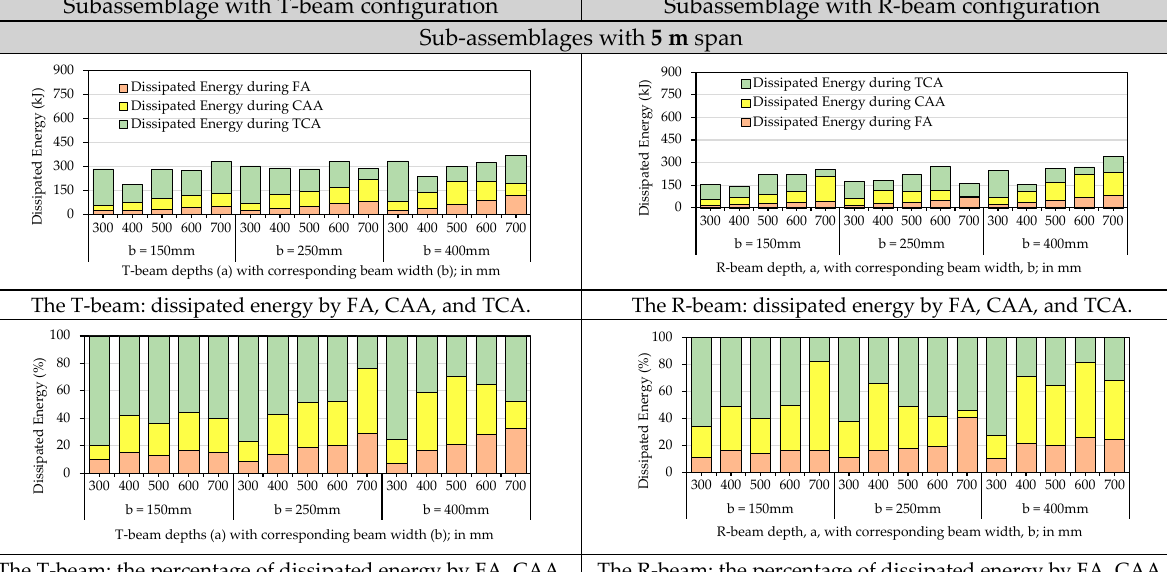
Figure 6. Load capacities of the different sub-assemblage designs. Subassemblage with T-beam configuration Subassemblage with R-beam configuration Sub-assemblages with 5 m span